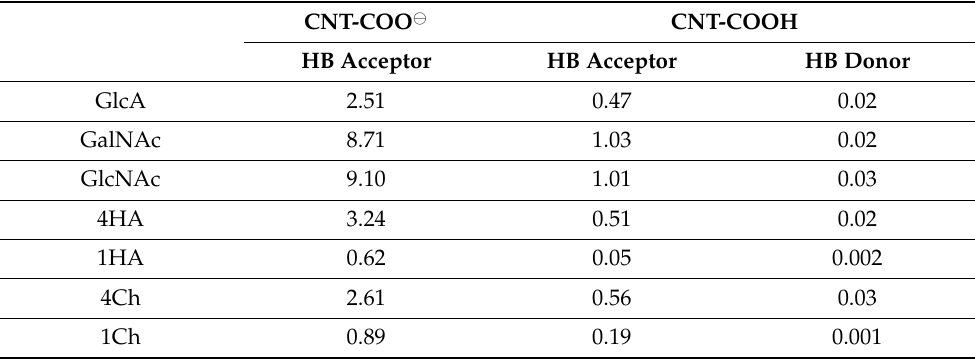
Table 2. Mean number of HB between the fCNT carboxylic and carboxylate groups and the carbohy- drate molecules determined using the following criterion: distance between acceptor and donor less than 3 Å, and angle acceptor-donor-H less than 20